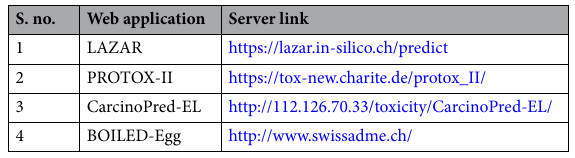
Table 1. List of utilized web